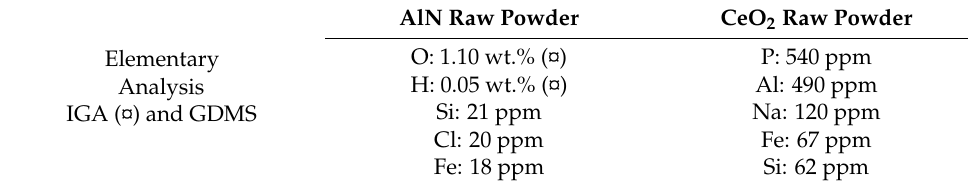
Table 1. Chemical analyses of raw powders.